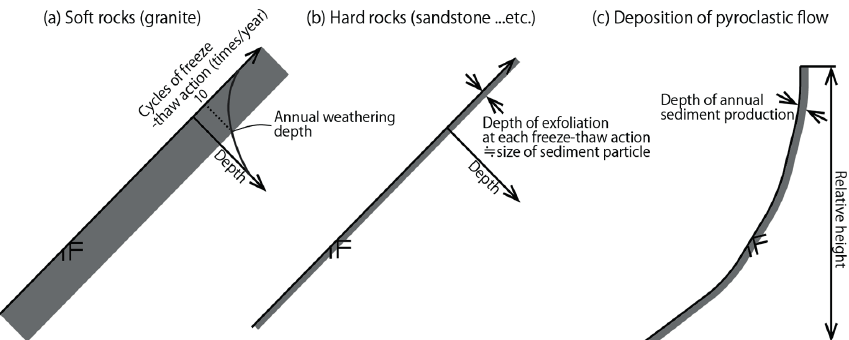
Fig. 2 Conceptual sketches of the sediment production processes on typical geological